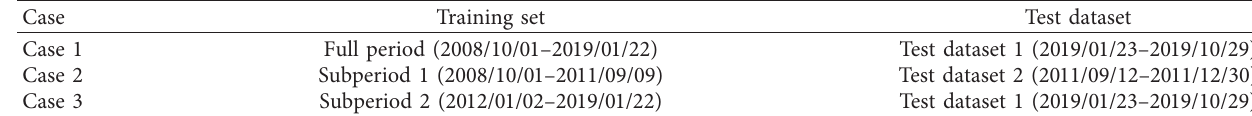
Figure 5: Comparison between (a) grid search and (b) random search. Table 3: Descriptions of the training and test datasets.